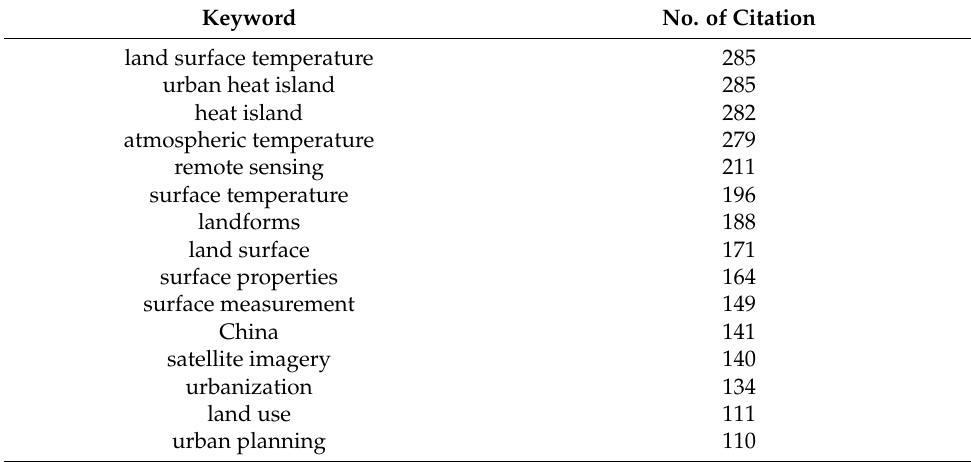
Table 4. Top 15 most frequently cited keywords.